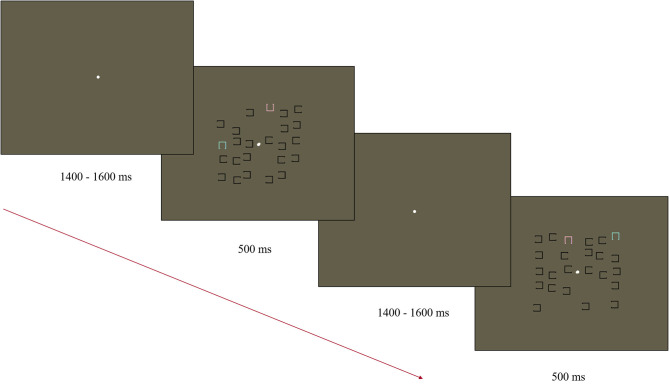
Diagram of the Visual Search Task used to elicit the N2pc. Participants were asked to find either the pink or blue “U” and indicate the direction of the open side (up/down).